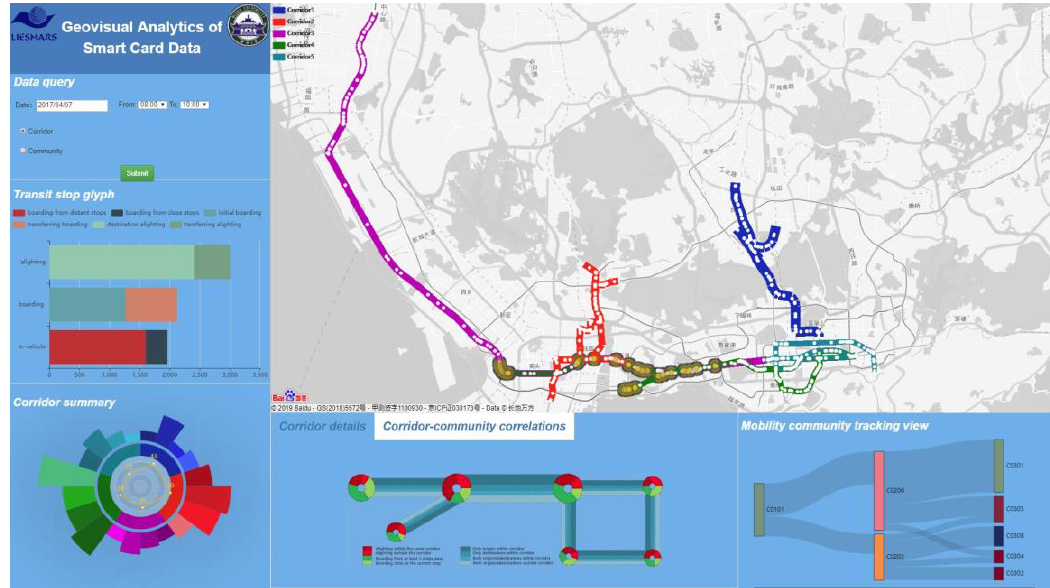
Table 1. Performance comparison of community detection using the modularity metric (low-level communities).